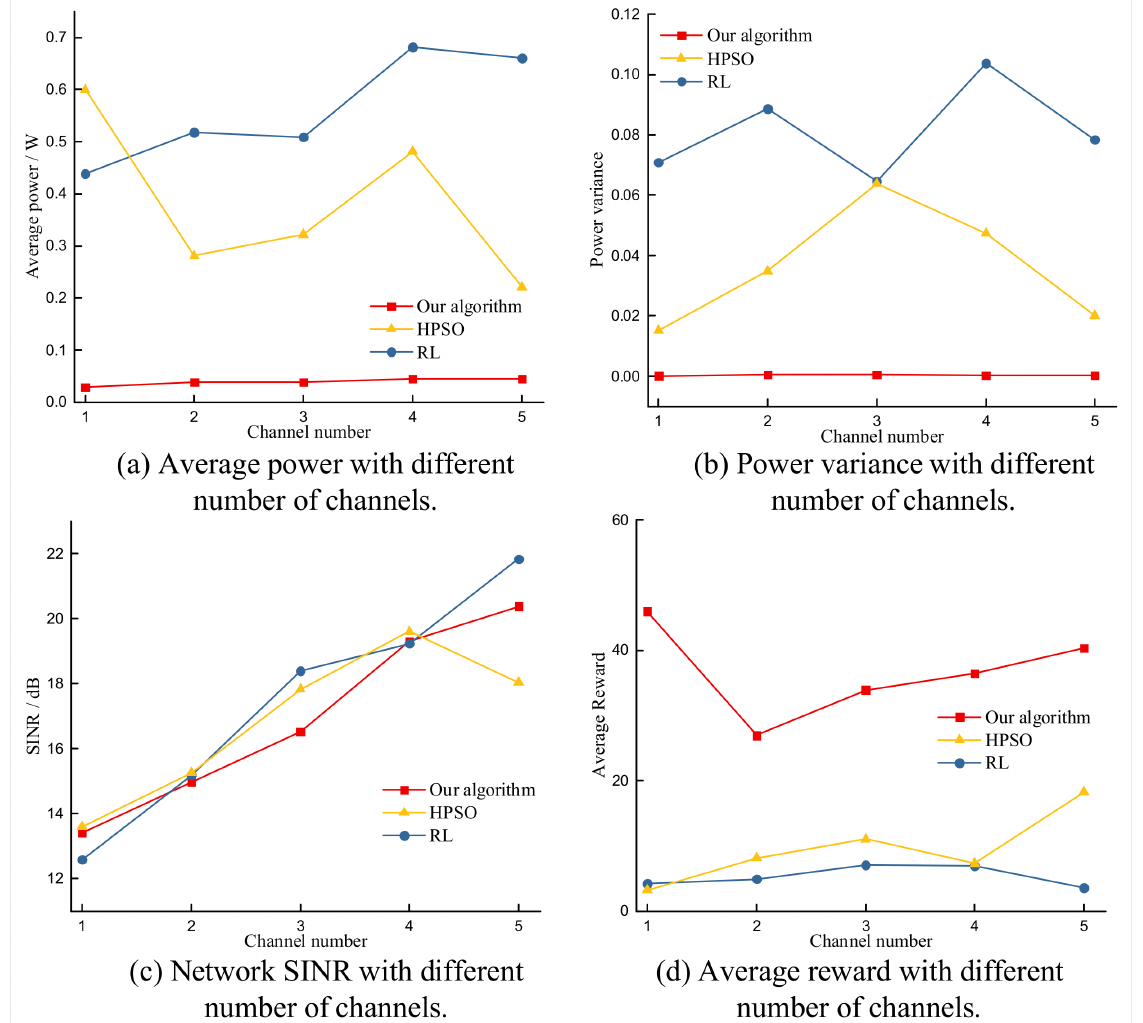
Figure 8. Network performance with different numbers of